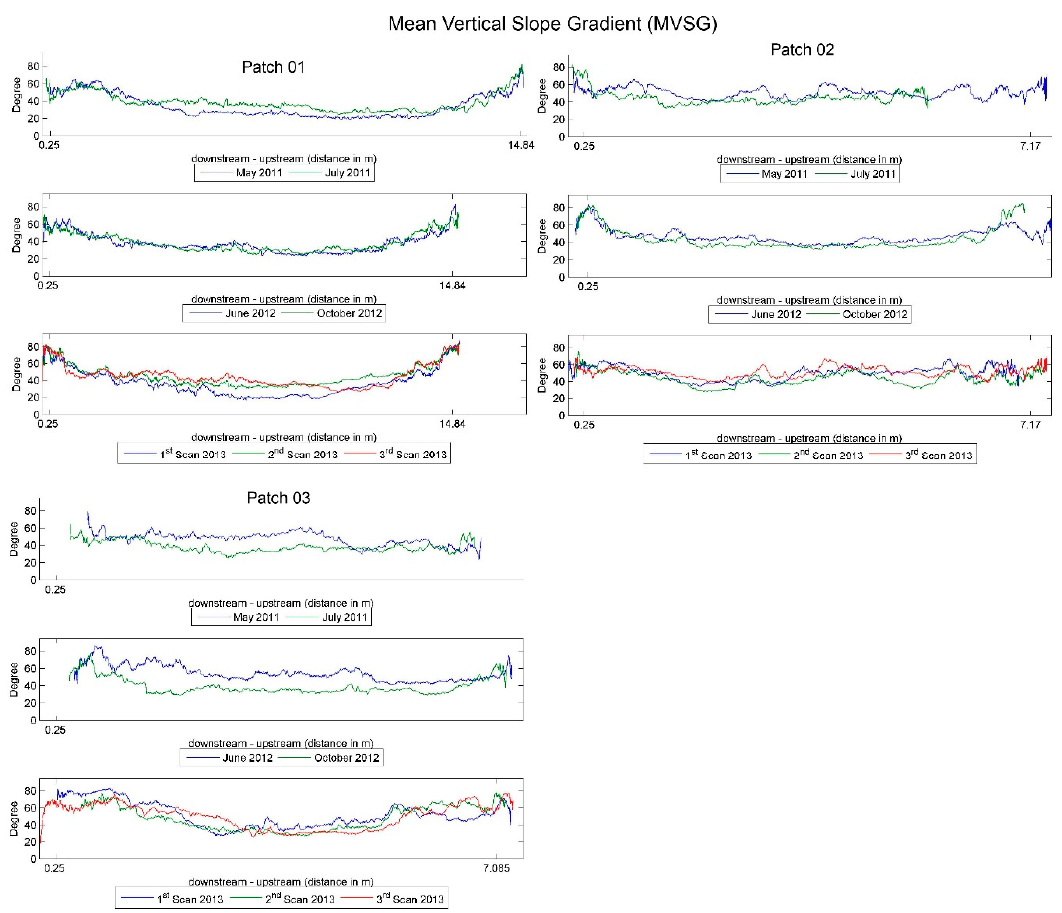
Figure 5. Change of mean vertical slope gradient for all patches during the study.